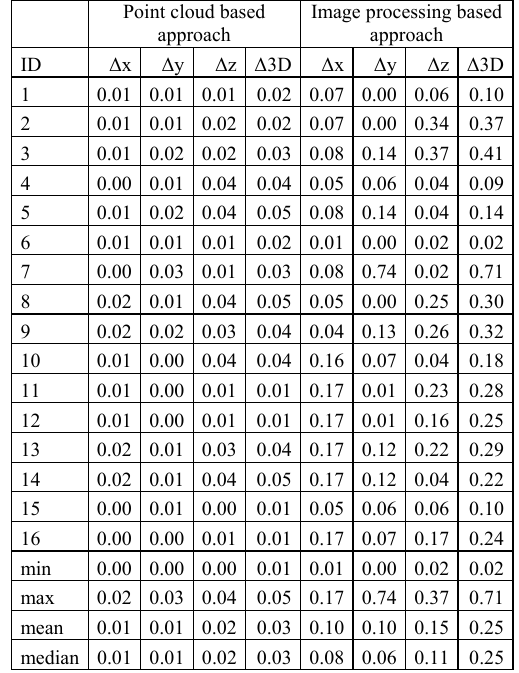
Table 2. Difference between reconstructed nodes and benchmark values in [cm] for synthetic building